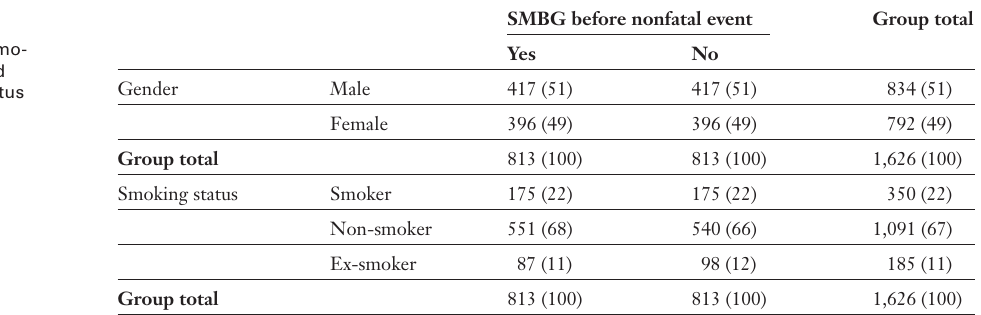
Baseline demo - graphics and smoking status [n (%)].